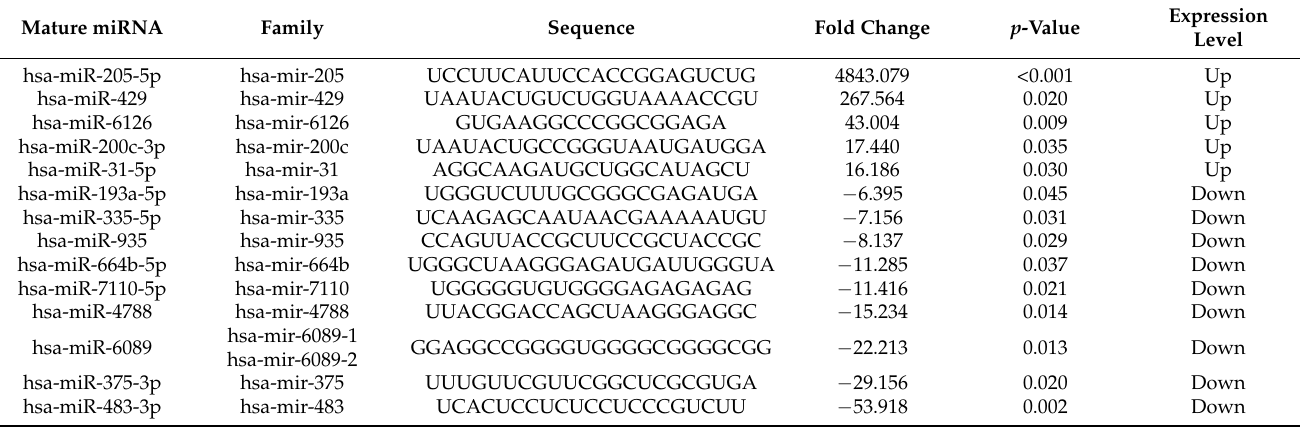
Figure 5. Expression levels of four plasma exosomal miRNAs in 20 healthy controls and 40 patients with esophageal squamous cell carcinoma. ( A ) miR-205-5p. ( B ) miR-429. ( C ) miR-375-3p. ( D ) miR-483-3p. Boxes represent interquartile ranges with bars representing minimum to maximum. Table 1. Five up-regulated miRNAs and nine down-regulated miRNAs in esophageal squamous cell carcinoma cell